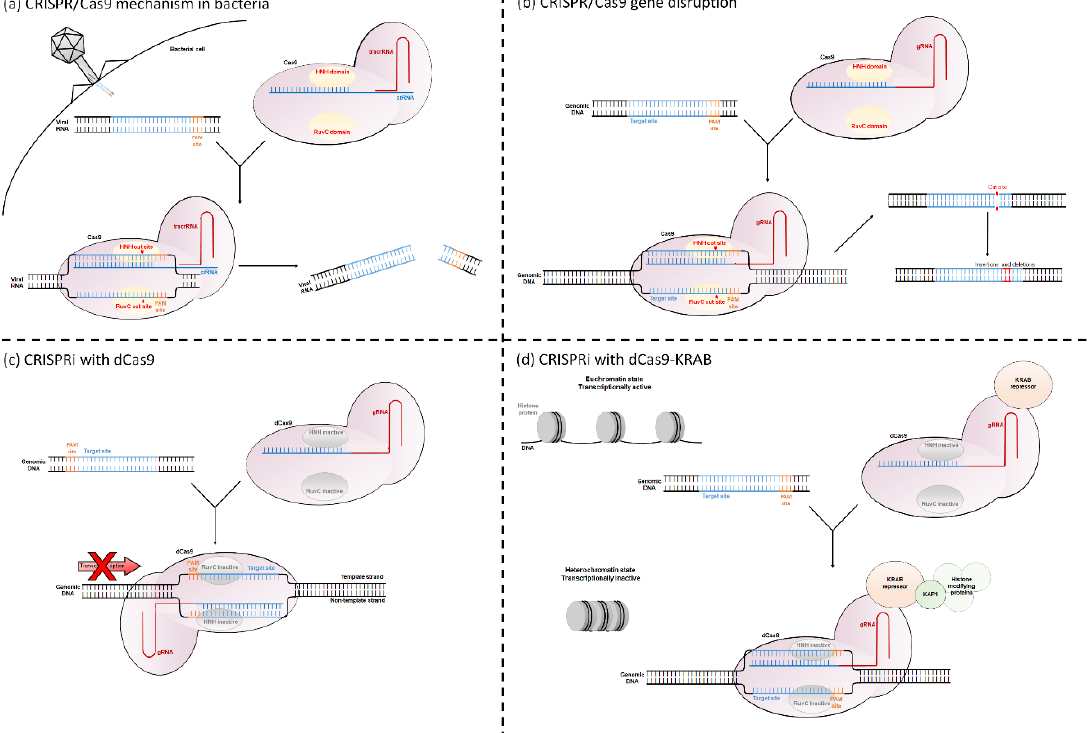
Figure 1. Mechanisms of CRISPR/Cas9 and CRISPRi. ( a ) CRISPR/Cas9 mechanism as a bacterial defence against invading viruses. ( b ) Using CRISPR/Cas9 to disrupt target genes. ( c ) Using CRISPRi with dCas9 to block transcription initiation or transcriptional elongation. ( d ) CRISPRi using a dCas9-KRAB fusion protein to alter the chromatin state of the